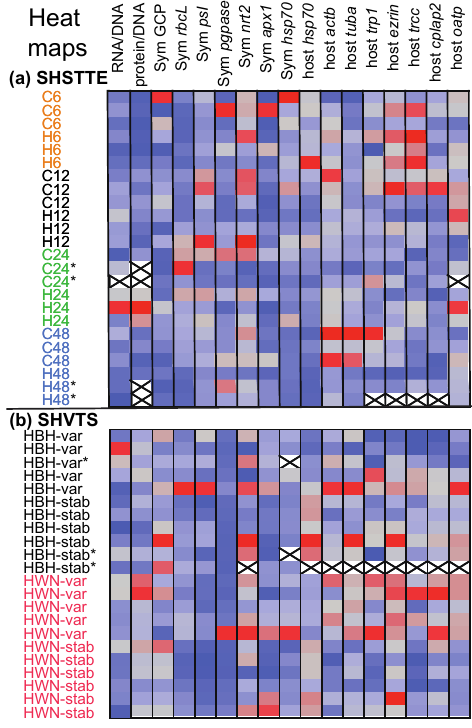
Figure 1. Heat maps of the Seriatopora hystrix short ‐ term temperature experiment (SHSTTE) and S. hystrix variable temperature study (SHVTS) datasets. The relative scale extends from dark blue ( Z ‐ score = − 3) to dark red ( Z ‐ score = 5) in the SHSTTE (a) and SHVTS (b) heat maps. “X”s denote missing data. Samples marked by asterisks (*) were excluded from most multivariate statistical approaches (MSA). Likewise, one sample from each of the Houbihu (HBH) ‐ variable (var) and Houwan (HWN) ‐ var groups was excluded from the heat maps themselves due to the respective RNA extractions having failed. Please see the main text for full names of the target genes. C = control temperature treatment. H = high temperature treatment. stab = stable.